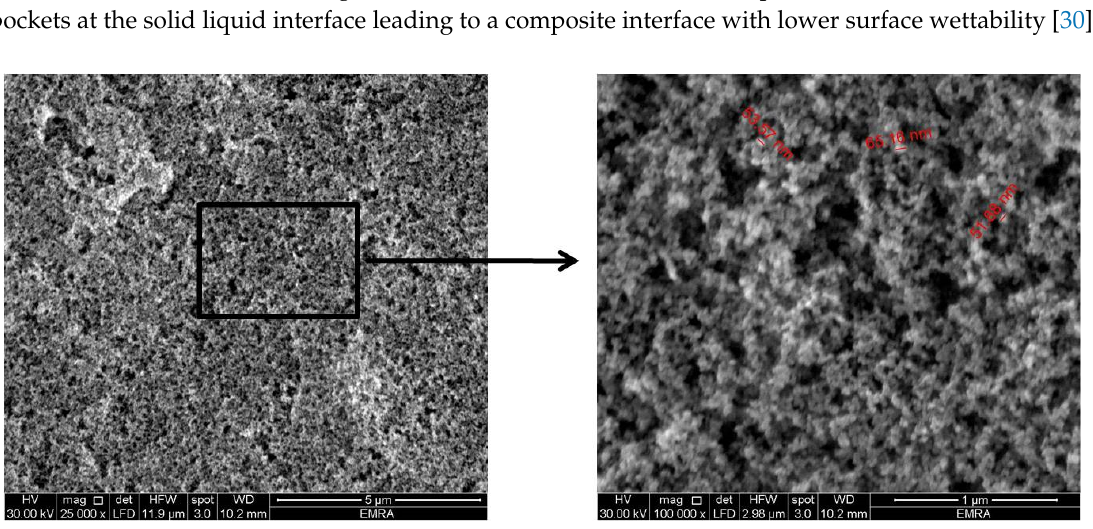
Figure 2. SEM images showing the nano-length hierarchical structure of the prepared superhydrophobic substrate (magnification power 25,000× and 100,000×).